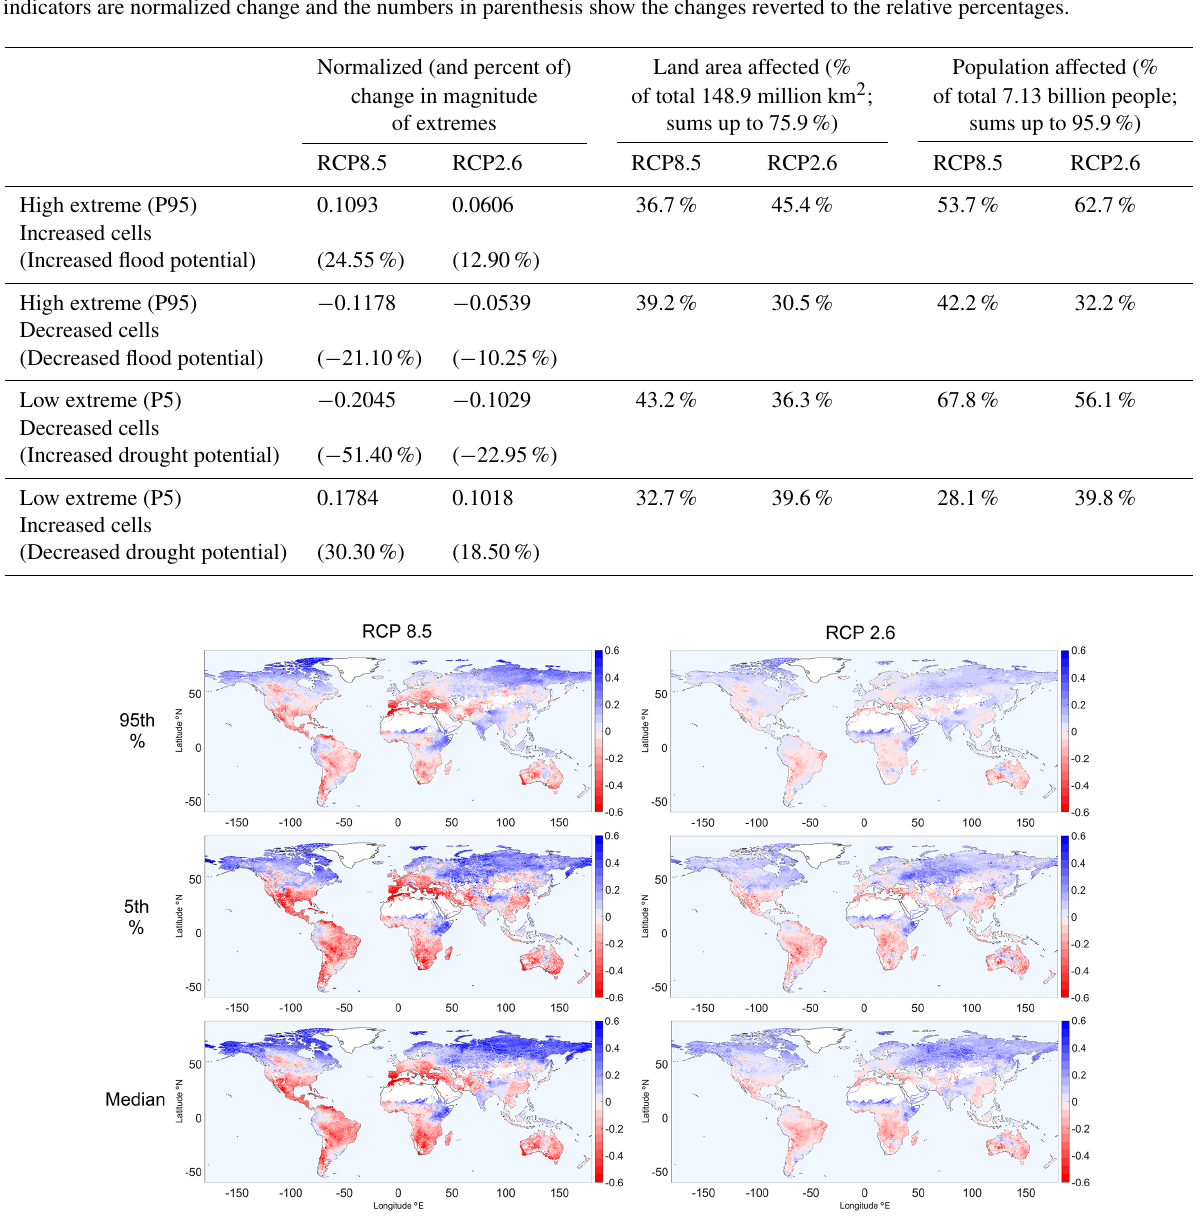
Figure 1. Global maps of normalized change in different streamflow percentiles (95th, 5th and median) under the RCP8.5 and RCP2.6 scenarios. Maps show the ensemble mean results of all 25